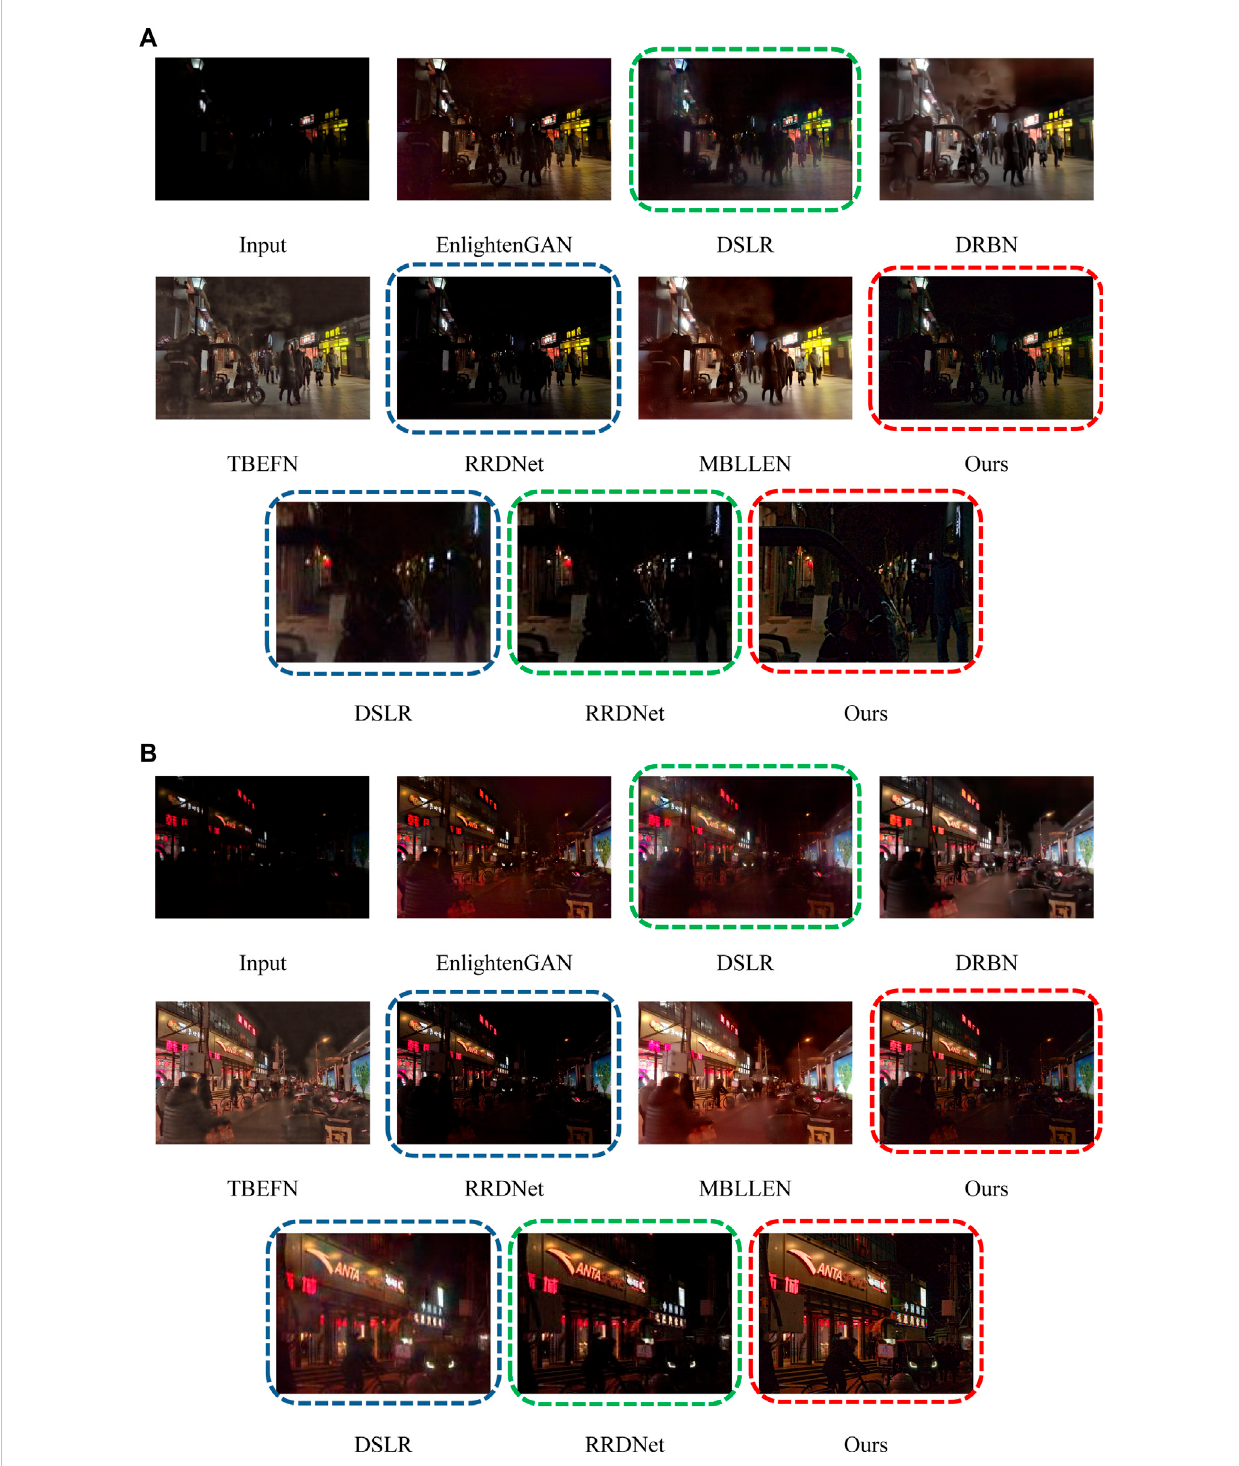
FIGURE 8 Vivid qualitative enhancement outcomes of recently competing network structures and our framework on the DARK FACE dataset. We present the results of SOTA methods on two speci fi ed images. We further compare the three most competing methods marked with boxes by zooming in on the local area of their enhanced results. Our method achieves the more superior enhancement results for real-world LL images than SOTA methods in respect of structural details and